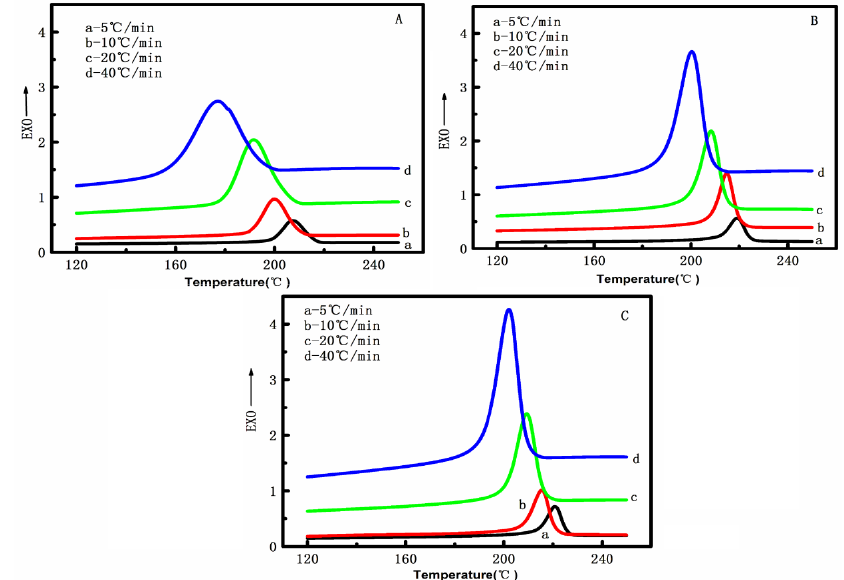
Figure 8. Non-isothermal melt-crystallization exothermal of ( A ) pure PET, ( B ) PET/CF, and ( C ) PET/PMMA-g-CF composites at different cooling rates. Table 2. Non-isothermal crystallization parameters of pure PET, PET/CF, and PET/PMMA-g-CF composites.